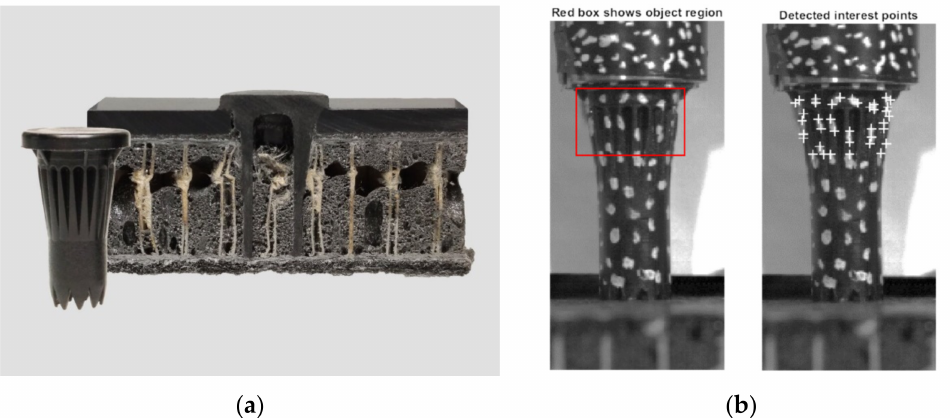
Figure 2. ( a ) Thermoplastic pin inserted in lightweight panel for high-strength fixation; ( b ) Detected points of interested on thermoplastic pin by usage of the Kanade–Lucas–Tomasi point tracking